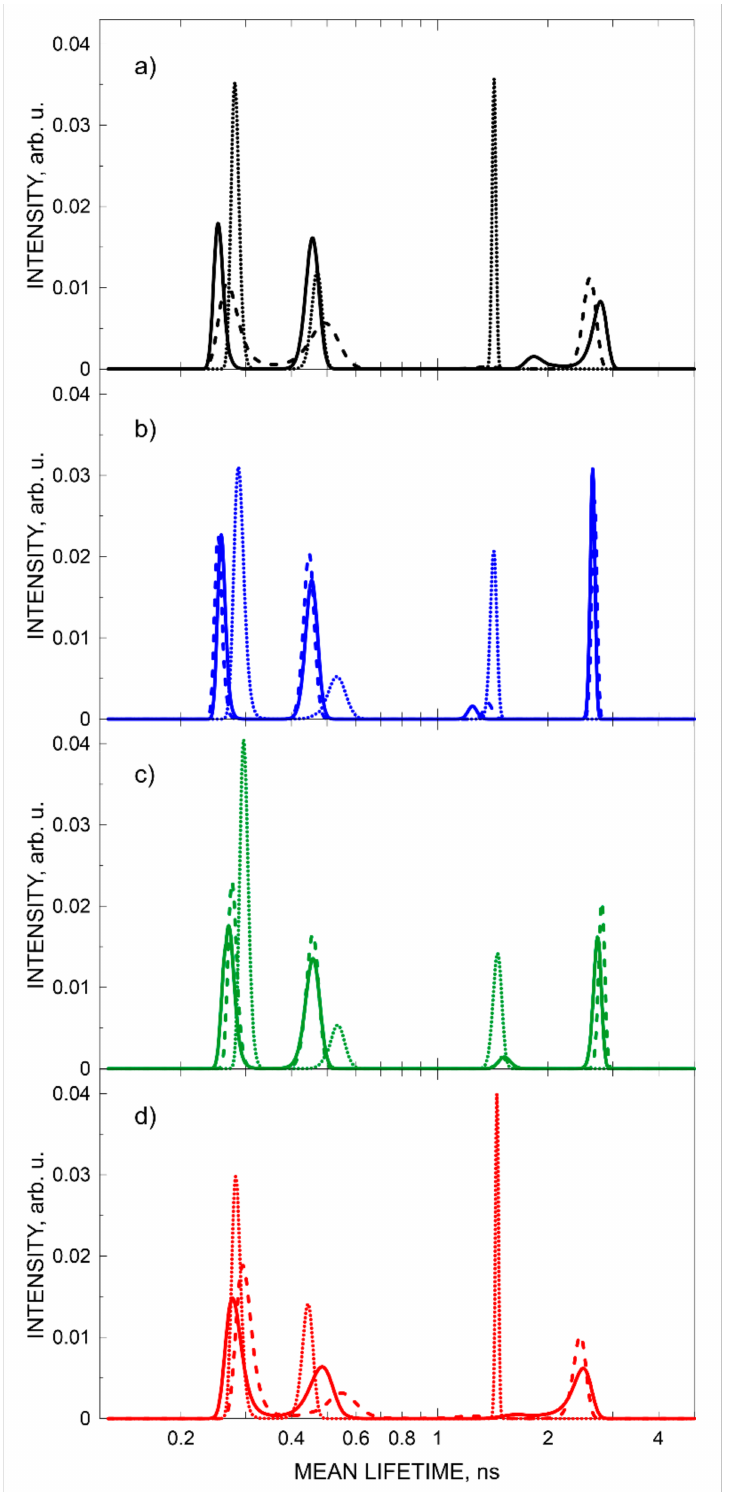
Figure 3. Distribution of mean lifetimes in the PALS spectrum of samples ( a ) ELO/PI, ( b ) ELO/10RD1/PI, ( c ) AESO/VDM, and ( d ) AESO/VDM/DMPA obtained from MELT processing of the spectra. Virgin sample at 18 ◦ C (solid line), sample at − 150 ◦ C (dotted line), and again at room temperature (dashed